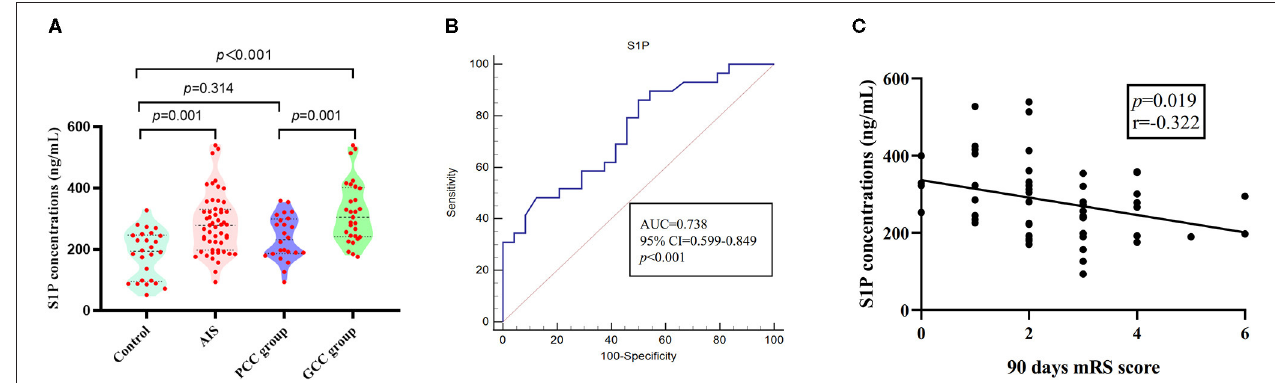
FIGURE 6 | S1P levels in patients with GCC and PCC in the validation stage. (A) In the validation stage, there were higher plasma S1P levels in AIS groups compared with control groups; the GCC group had higher plasma S1P levels than PCC groups. (B) The ROC analysis of plasma S1P levels showed an AUC of 0.738 (95% CI: 0.599–0.849) to differentiate patients with GCC from PCC. (C) Plasma S1P levels showed a significant negative correlation with the 90-day mRS score. GCC, good collateral circulation; PCC, poor collateral circulation; ROC, receiver operating characteristic curve; AUC, area under the curve; S1P, sphingosine-1-phosphate.